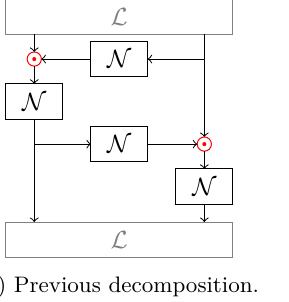
Figure 1: A simplied view of previous and our new decompositions of 𝜋 . Linear (resp. nonlinear) functions are denoted ℒ (resp. 𝒩 ). ⊙ denotes finite field multiplication and log is a finite field logarithm. 𝒜 denotes a few simple integer arithmetic operations. Linear functions are represented in grey, finite field operations in red and integer operations in